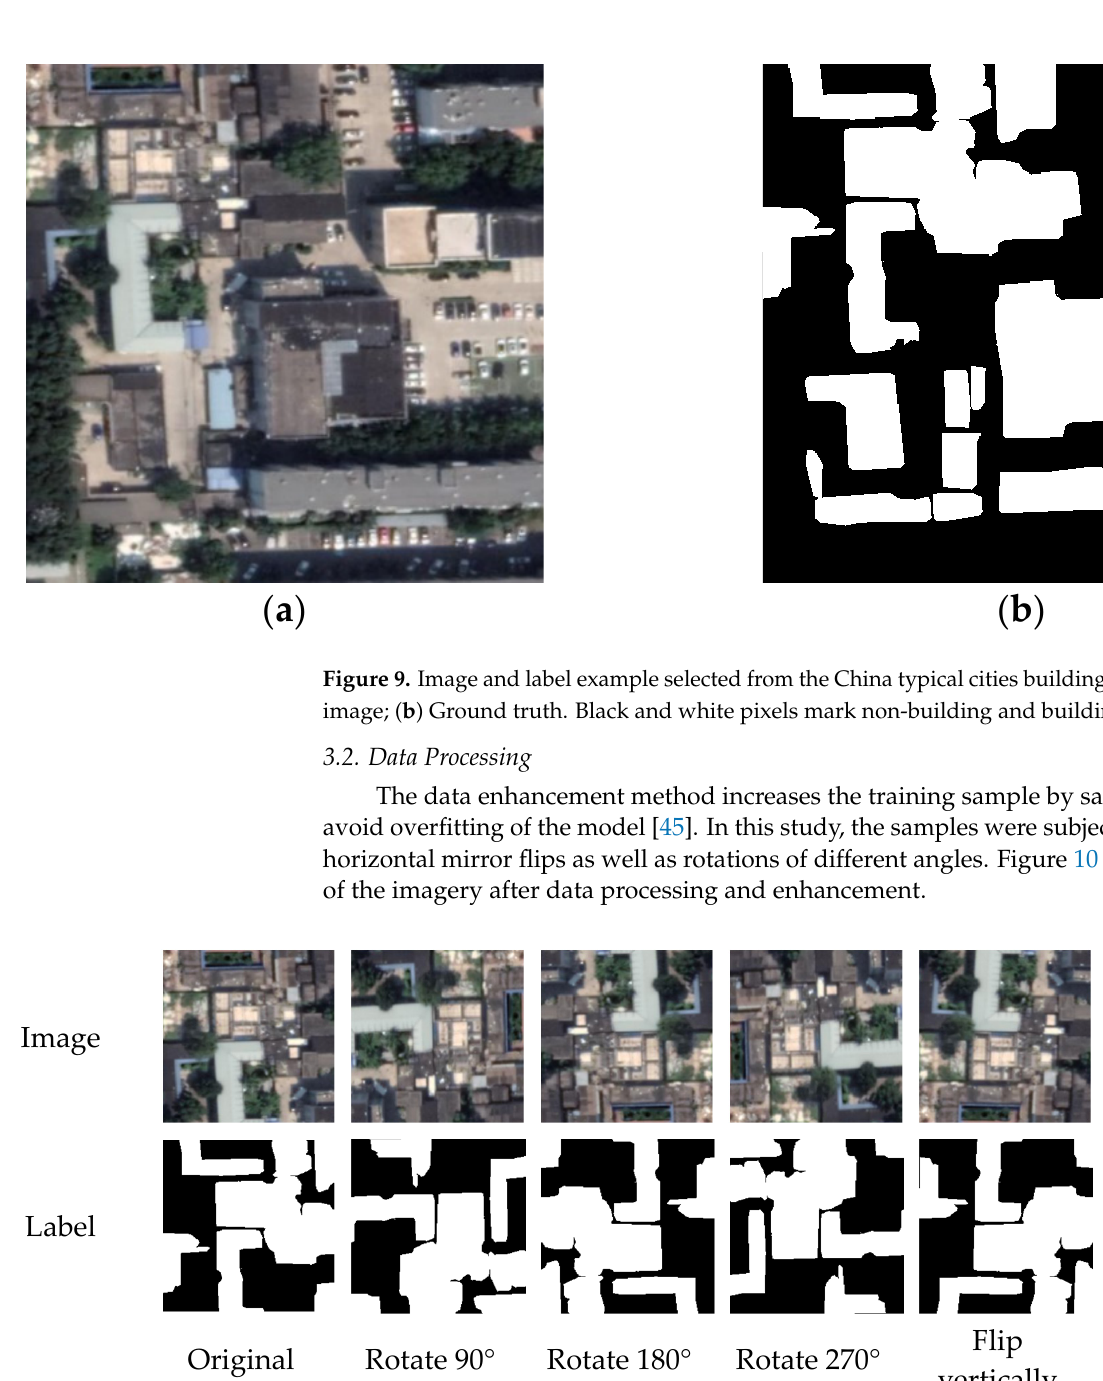
Figure 10. An example of data augmentation by rotating and flipping.